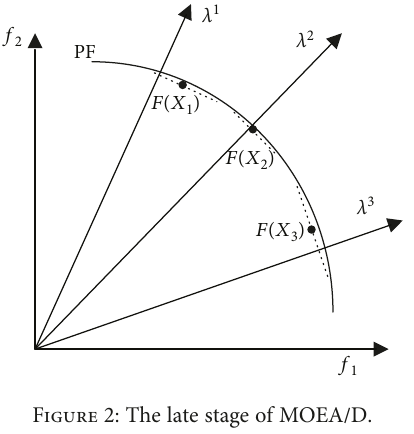
Figure 2: The late stage of MOEA/D.